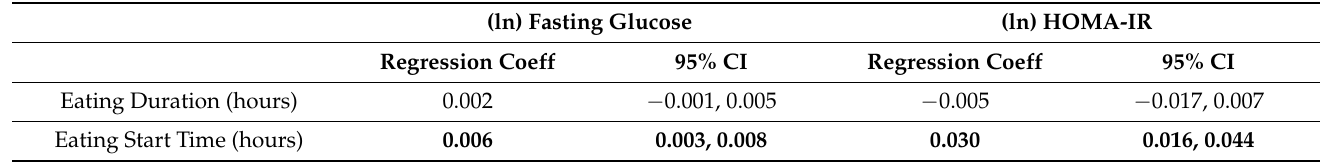
Table 2. Results from regression models examining associations between fasting glucose, HOMA-IR, and eating duration and start time a